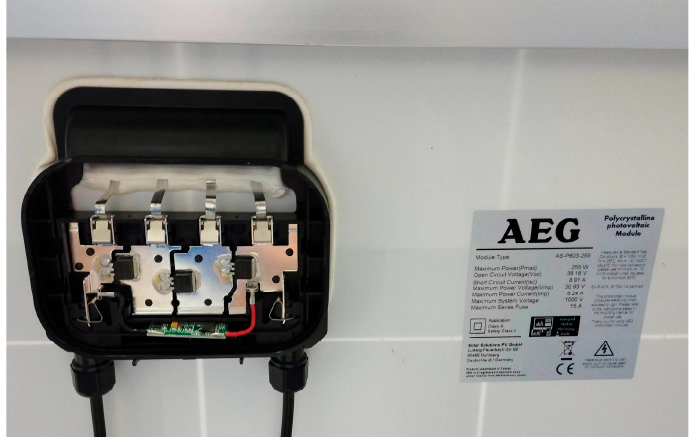
Figure 1. Intelligent PV module.